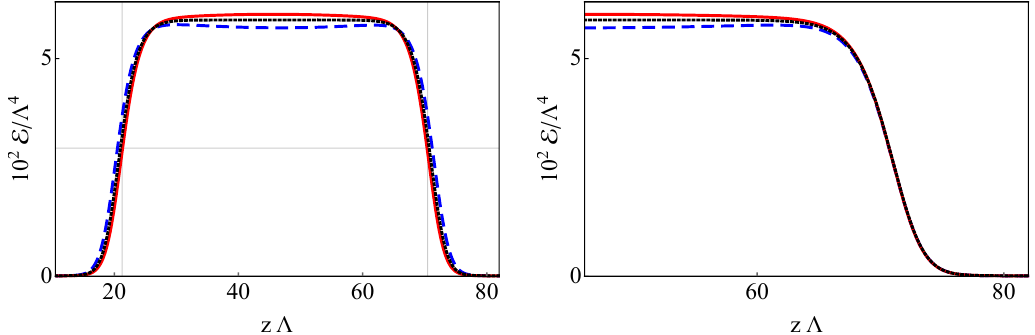
Figure 25 . (Left) Late-time oscillations of the (cid:12)nal domain in (cid:12)gure 4 once the size of the per- turbation created by the last merger has become comparable to the size of the domain itself. The distance between vertical lines is half a wavelength, (cid:21) 2 = 2. The horizontal line is the half of the en- ergy of the hot stable phase. (Right) Same curves as on the left plot shifted by a constant amount in order to illustrate that the interface oscillates